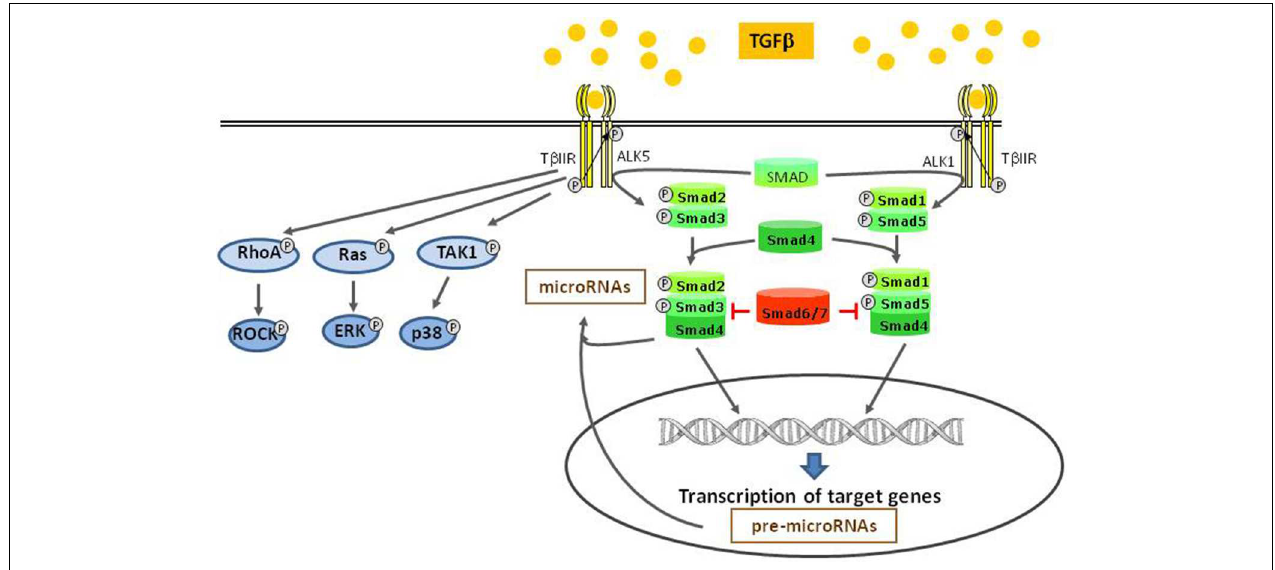
FIGURE 1 | TGF β -signaling pathways. After binding to TGF β II receptor, different type I receptors (ALKs) can be activated and induce the canonical SMAD pathways. This pathway takes influence on miRNA modulation, either